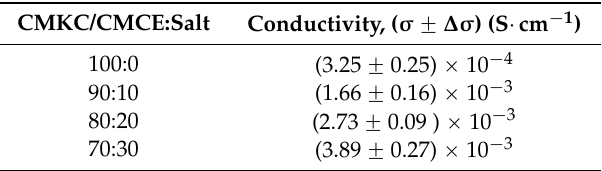
Table 3. Conductivity and relative number of charge carriers for the CMKC/CMCE-LiI films at room temperature.